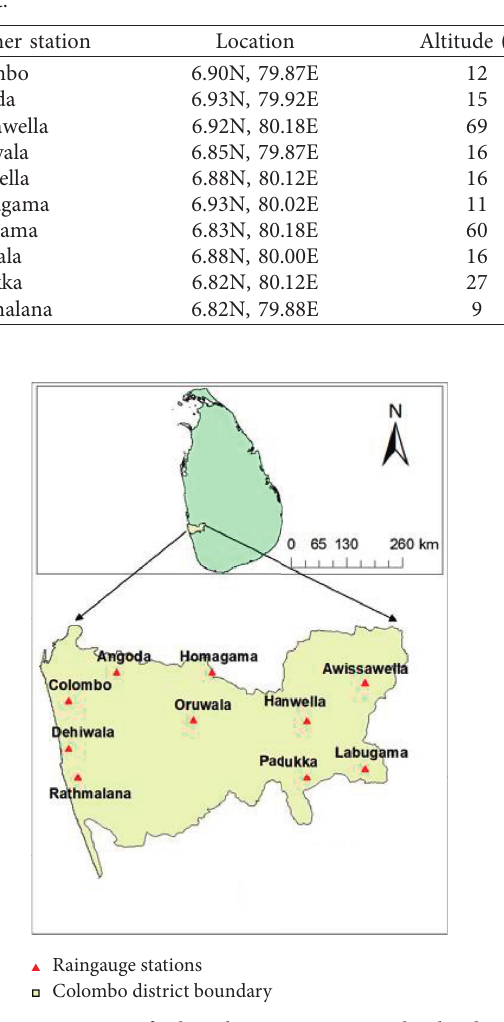
Figure 1: Locations of selected rain gauges in Colombo